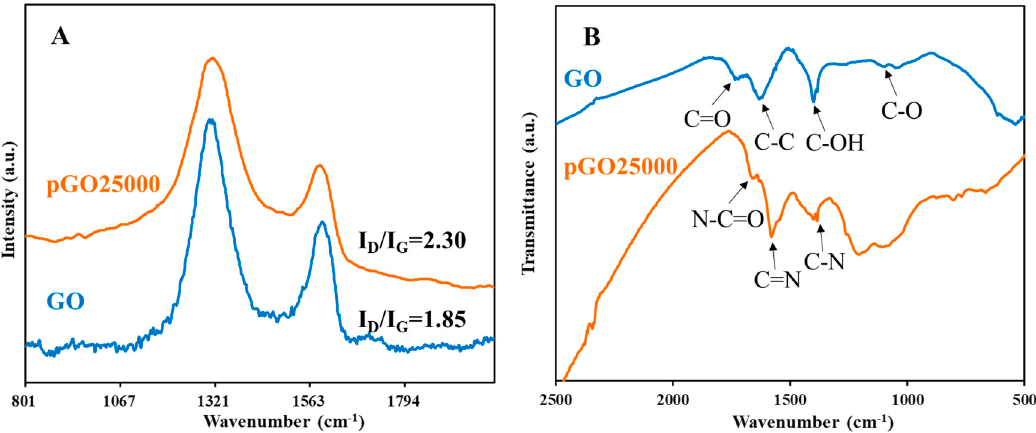
Figure 2. Characterization of GO and pGO25000 by ( A ) Raman spectroscopy and ( B ) FT-IR.